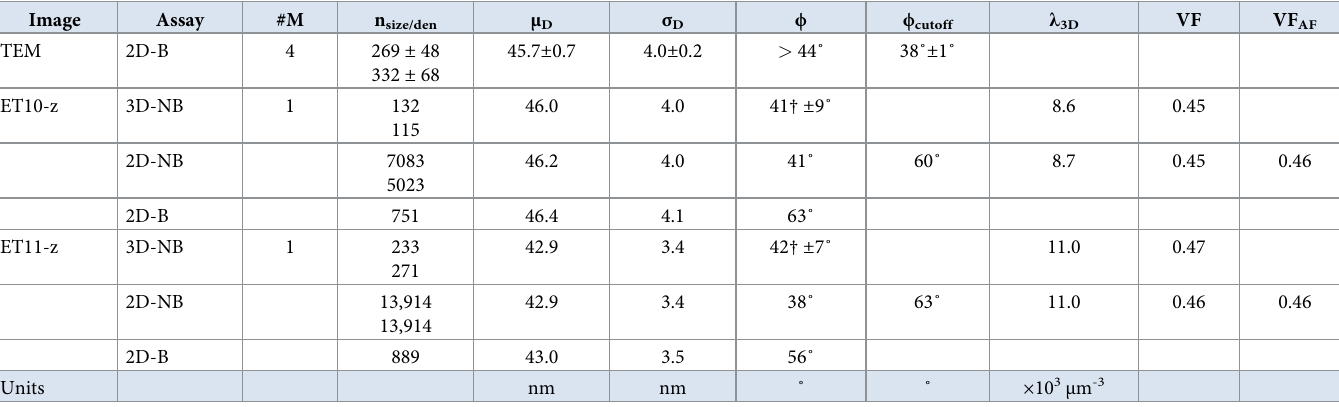
systematic deviation at the smaller diameters (d = 20–40 nm; Fig 6D; S8D and S10A Figs in S1